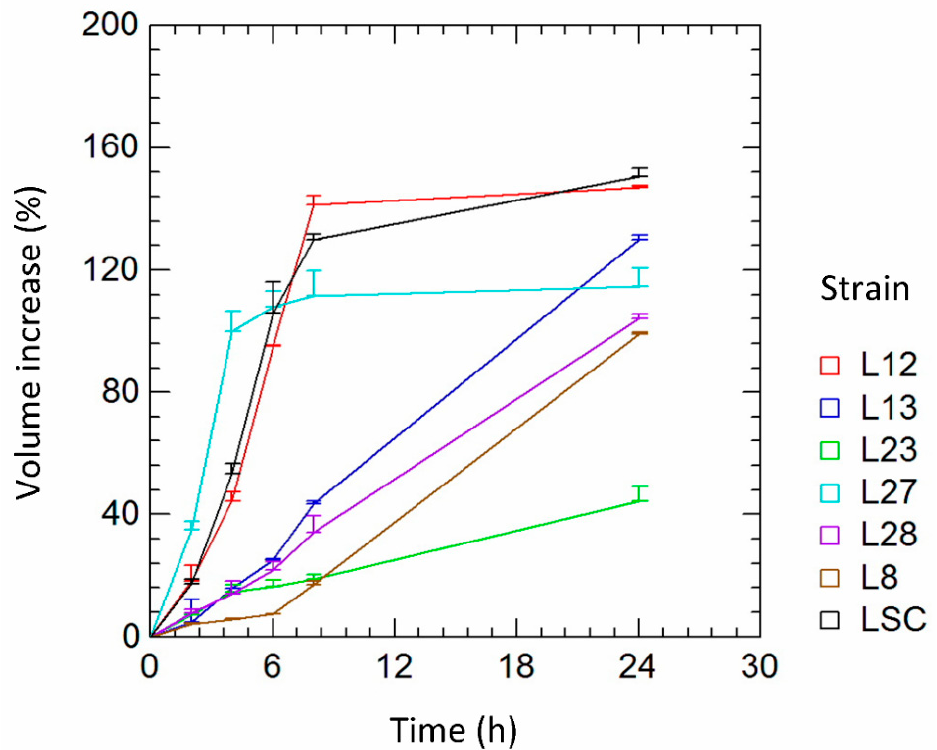
Figure 3. Leavening kinetics of the selected yeast strains. L12, L27: S. cerevisiae ; L8, L13, L23, L27, and L28: H. uvarum ; LSC: commercial yeast that was used as control.